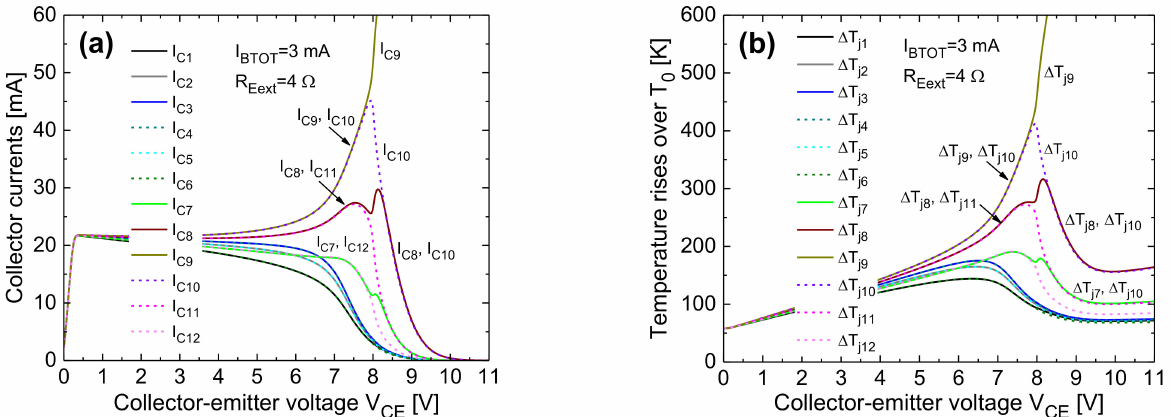
Figure 22. Simulated ( a ) collector currents and ( b ) junction temperature rises above T 0 for the 12 cells of the halved 24-cell array ballasted with R Eext = 4 Ω per cell, and biased with I BTOT = 3